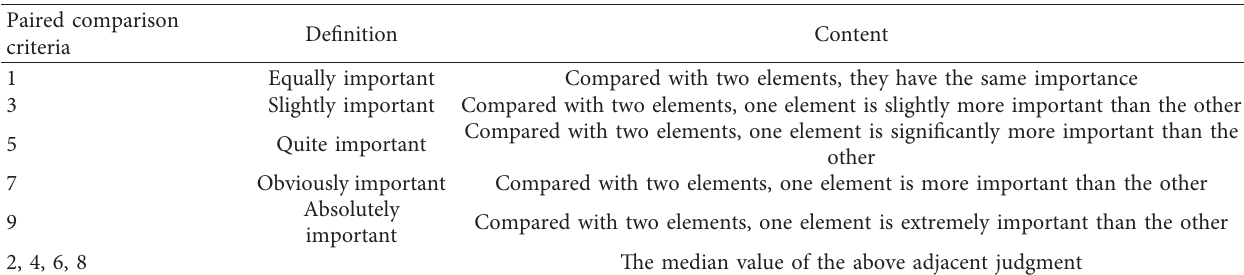
Table 3: 1–9 scaling method.